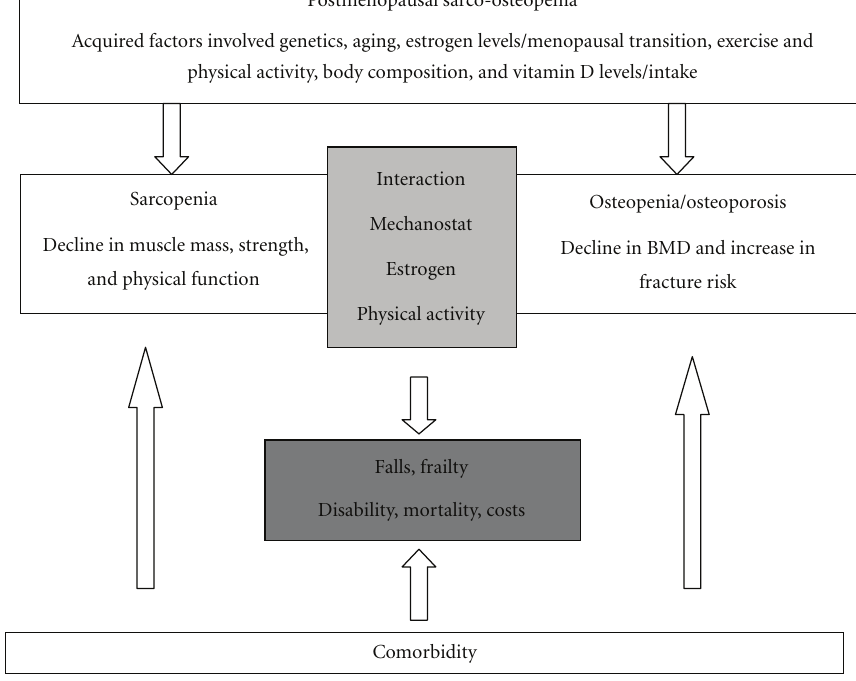
Figure 1: Dimensions of postmenopausal sarcopenia, osteoporosis, and frailty